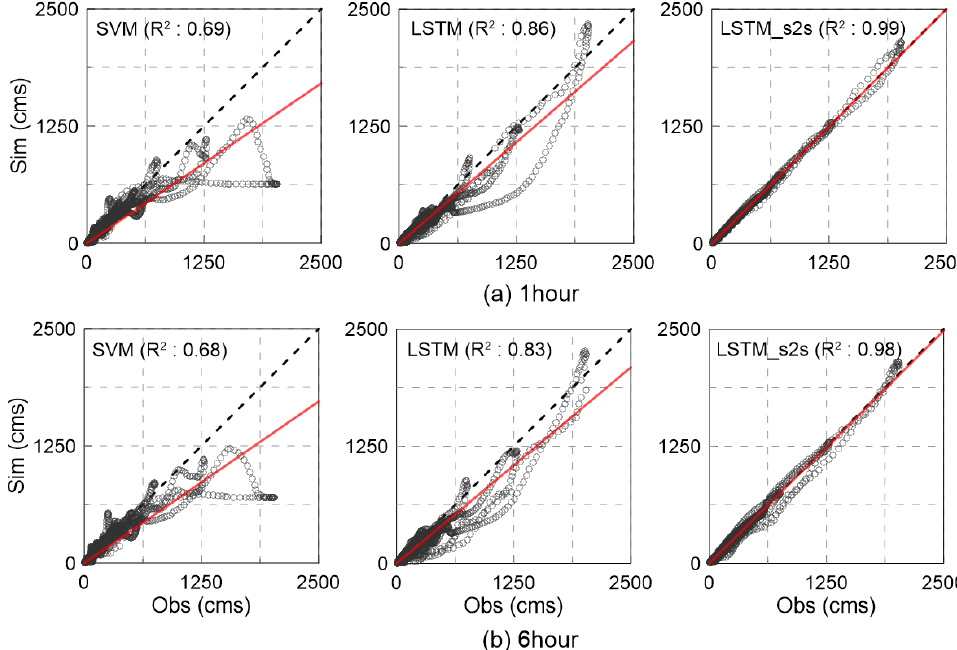
Figure 5. Comparison results of predicted runoff with observations for lead time of ( a ) 1 h and ( b ) 6 h. Red line indicates regression line of two runoff data.